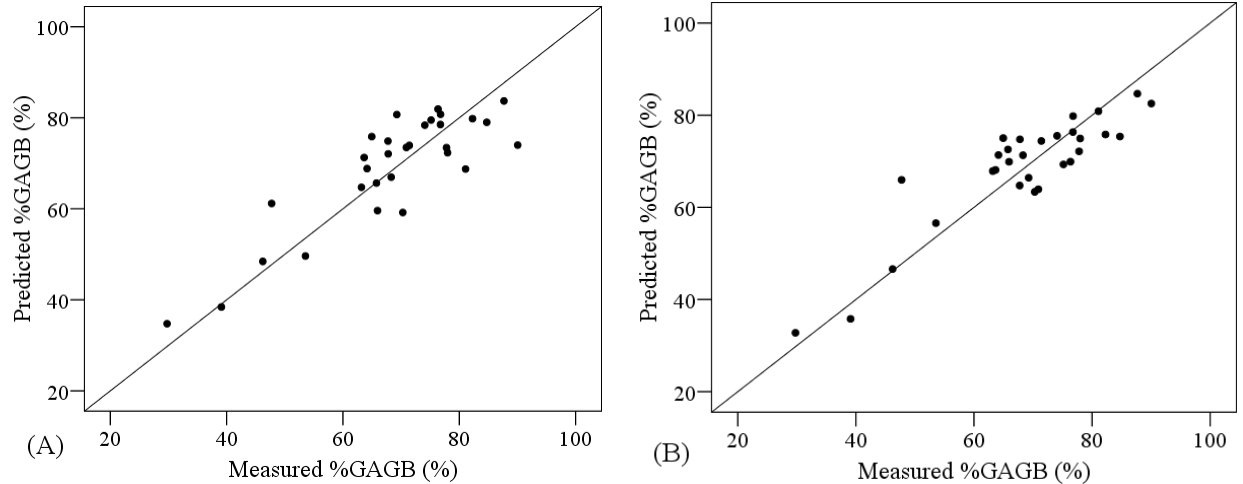
Figure 6. Cross-calibration results for predicting %GAGB using ( A ) PLSR based on the continuum-removed reflectance between 440 and 567 nm (Z1) and ( B ) SVM based on VNIR non-transformed data. One-to-one line is